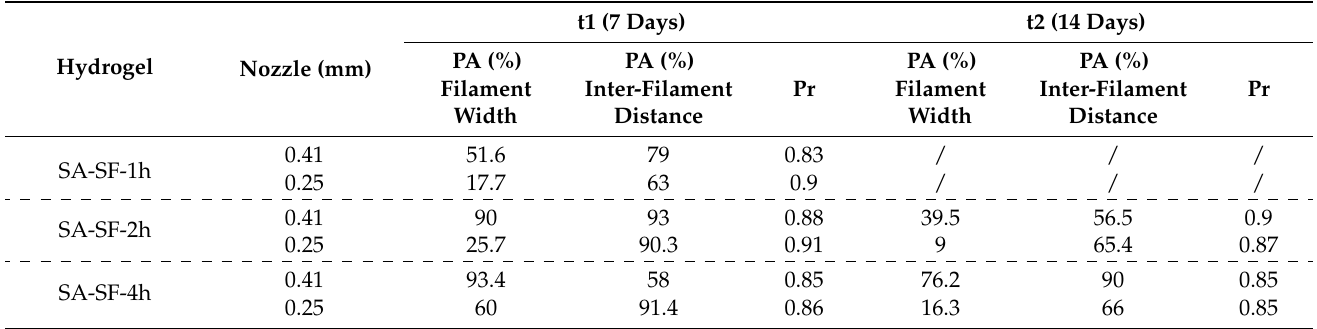
Table 6. Characterization of each formulation regarding the degree of PA% and